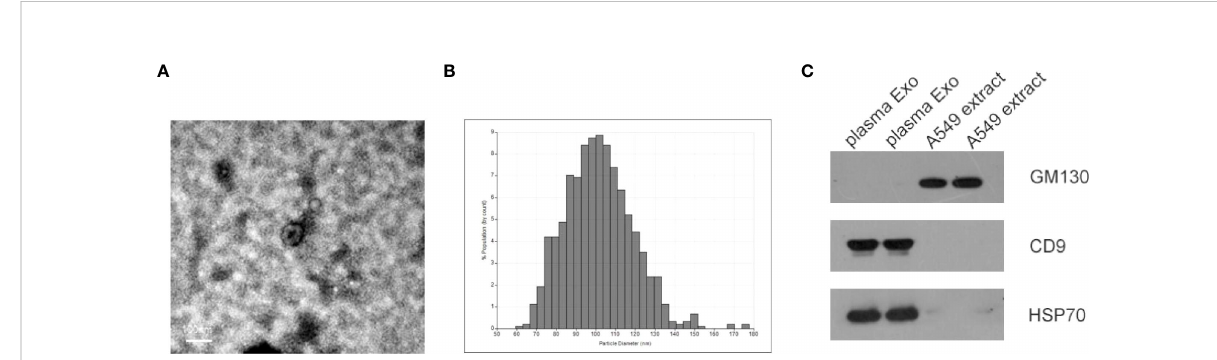
FIGURE 1 Characterization of isolated plasma exosomes. (A) TEM image showed representative data of exosomes with a diameter of 50-150 nm isolated from the plasma of NSCLC patients. (scale bar: 100 nm; high voltage (HV) = 80 kV). (B) Plasma exosome diameter detection based on qNano system, with diameters mainly distributed in the range of 70-150 nm (C) Western blot analysis of cell protein markers: GM130, and exosomal protein markers: CD9 and